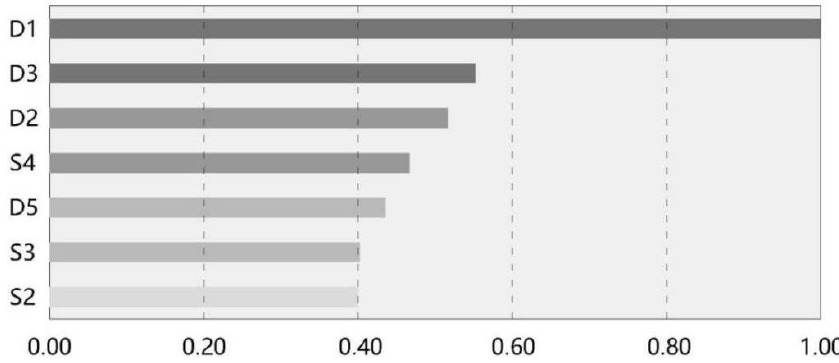
Figure 5. Importance ranking of variables influencing the clustering.